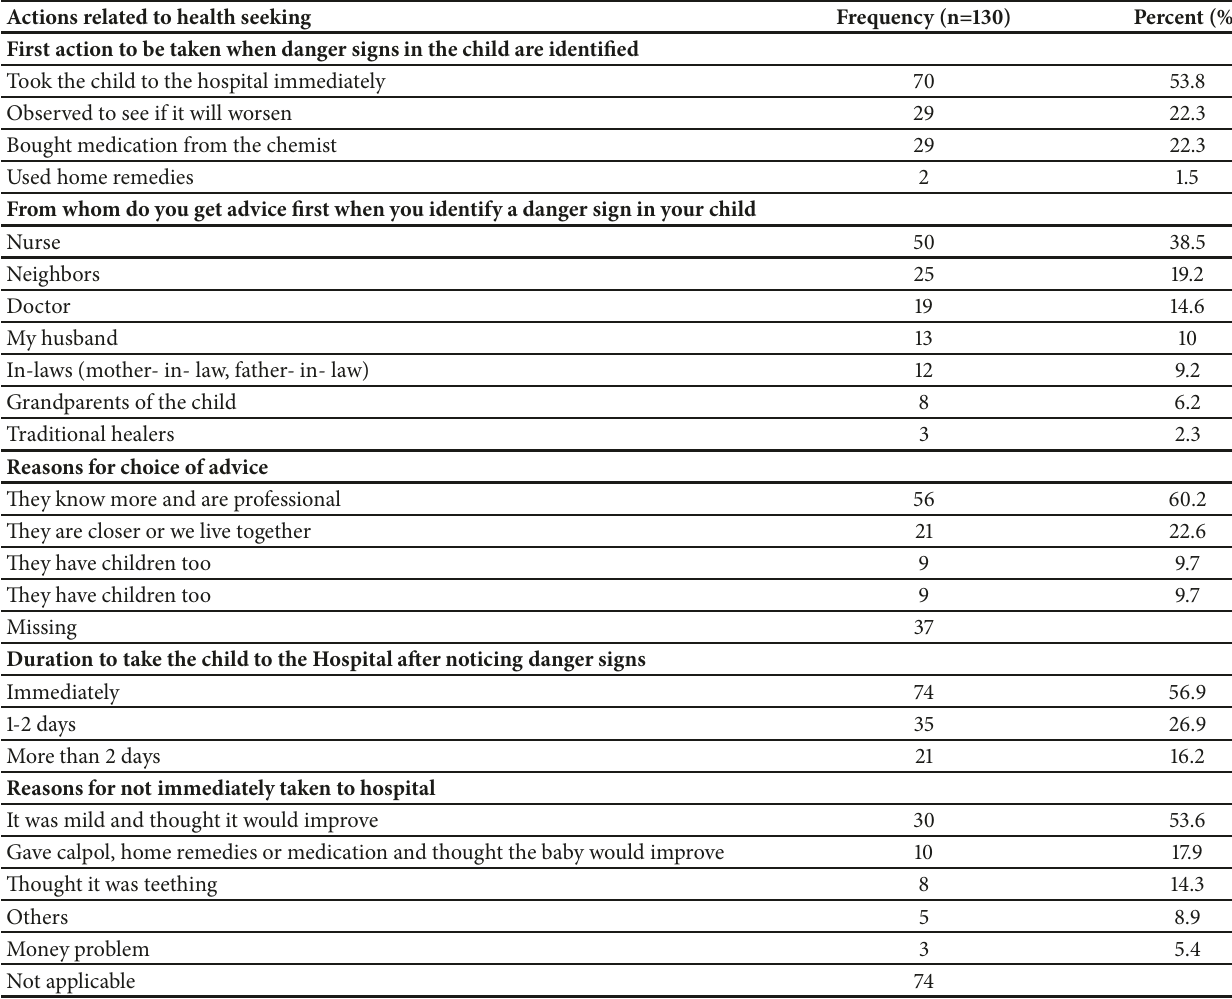
Table 2: Actions related to health seeking among